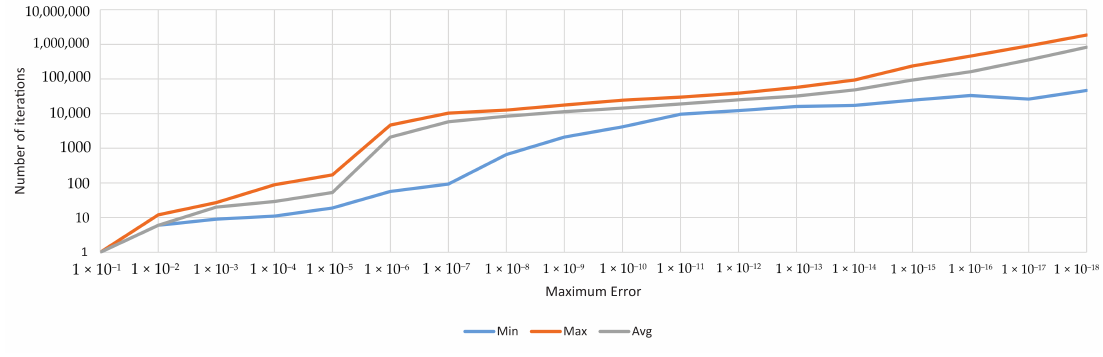
Figure 14. The convergence speed—the accuracy in the point of view of necessary iterations